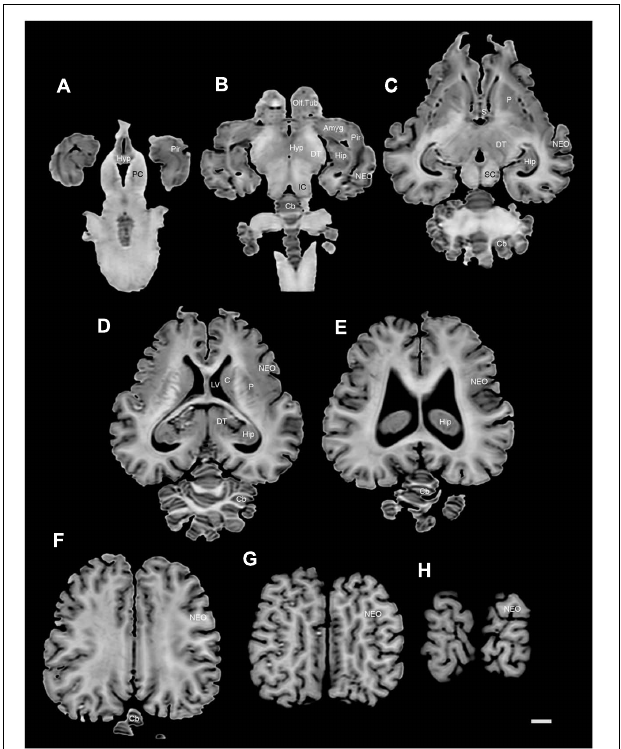
FIGURE 6 | A series of horizontal structural MR images through the brain of the black rhinoceros ( D. bicornis ). (A) is the most ventral section and (H) is the most dorsal section, with each section having a thickness of 2 mm and each section being 6 mm apart. Note the typically mammalian topography of the various regions and structures of the brain. Scale bar = 1 cm. Amyg, amygdaloid body; C, caudate nucleus; Cb, cerebellum; DT, dorsal thalamus; Hip, hippocampus; Hyp, hypothalamus; IC, inferior colliculus; LV, lateral ventricle; NEO, neocortex; Olf. Tub, olfactory tubercle; P, putamen; PC, cerebral peduncle; Pir, piriform cortex; SC, superior